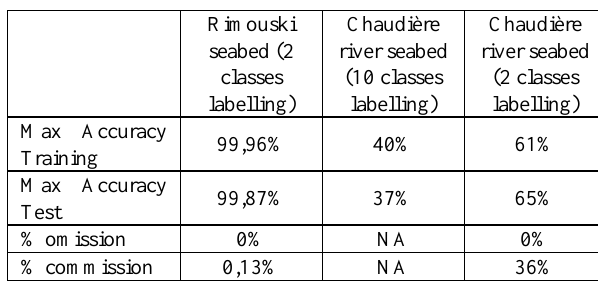
Table 2. Performance measures provided by the three experiments (NA: not